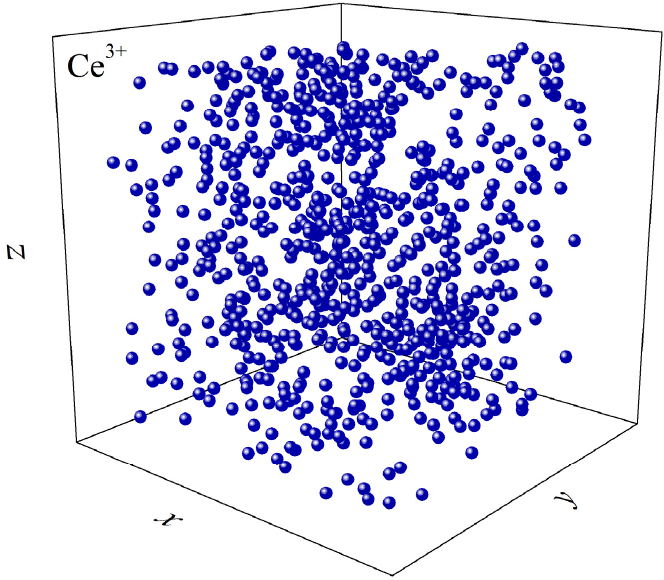
Figure 3. Configuration of Ce subsystem extracted from the FLiNaK+Ce system at instant 200 ps at 1000 K.